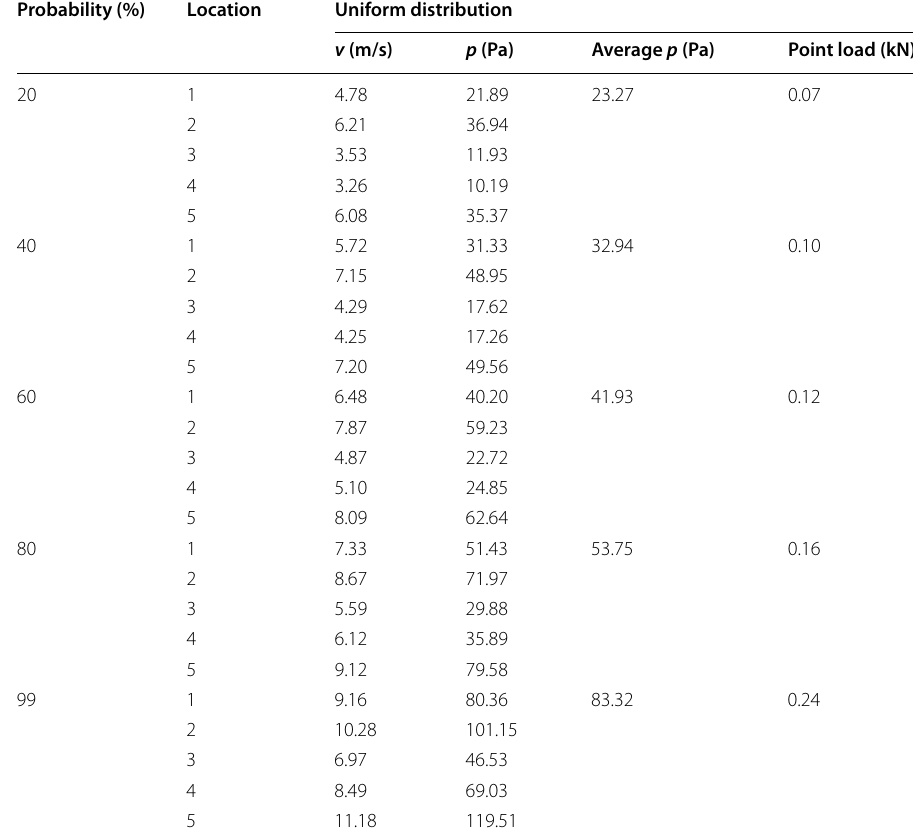
v wind velocity; p =